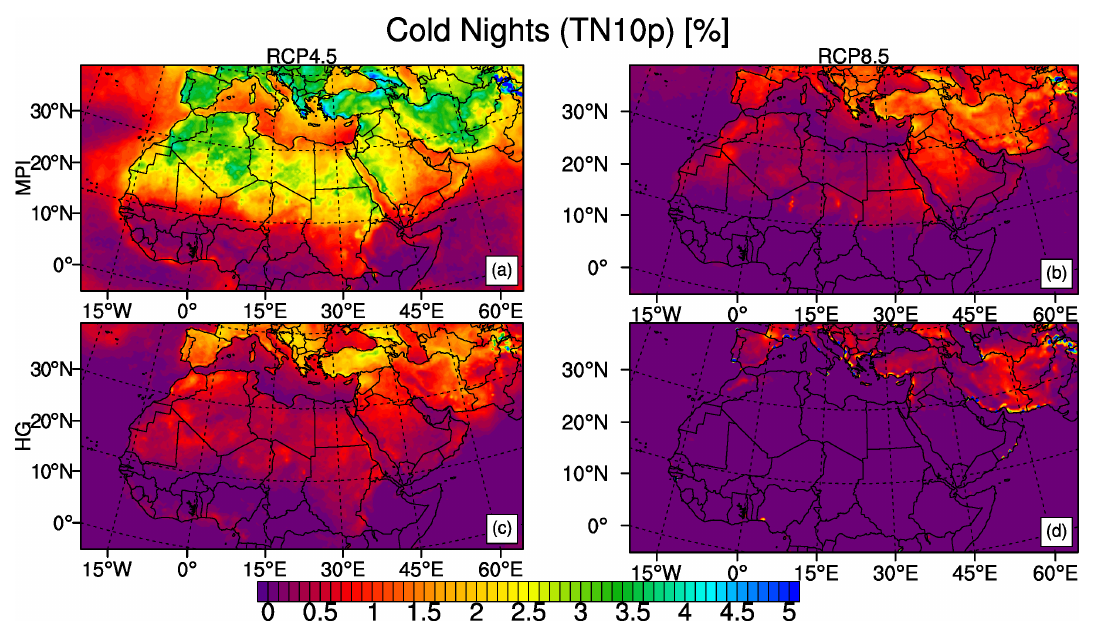
Figure 7. Annual frequency of TN10p temporally averaged over the period of 2071–2100 as absolute values of the exceedance rate (in %) for the model MPI-ESM-MR with RCP4.5 ( a ) and RCP8.5 ( b ) and for the model HadGEM2-ES with RCP4.5 ( c ) and RCP8.5 ( d ). By definition the exceedance rate averages to approximately 10% over the reference